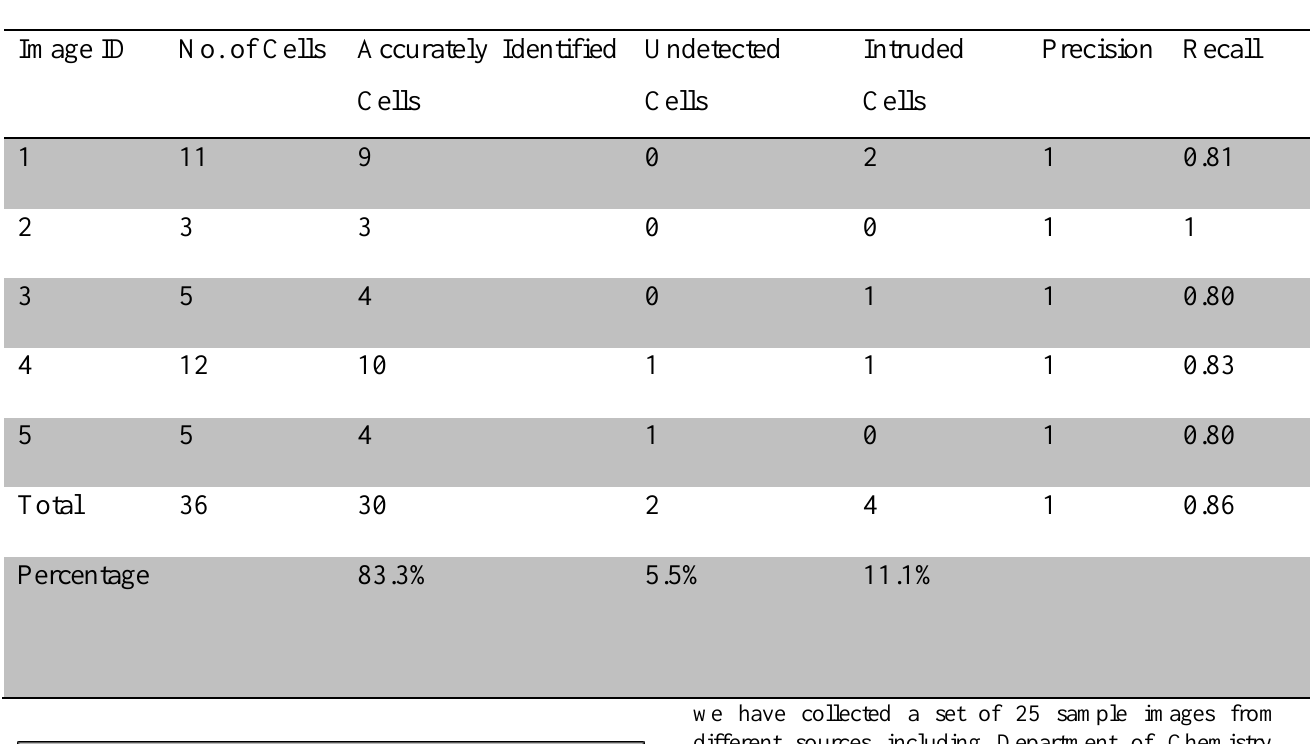
Table 3: Test sample Image results